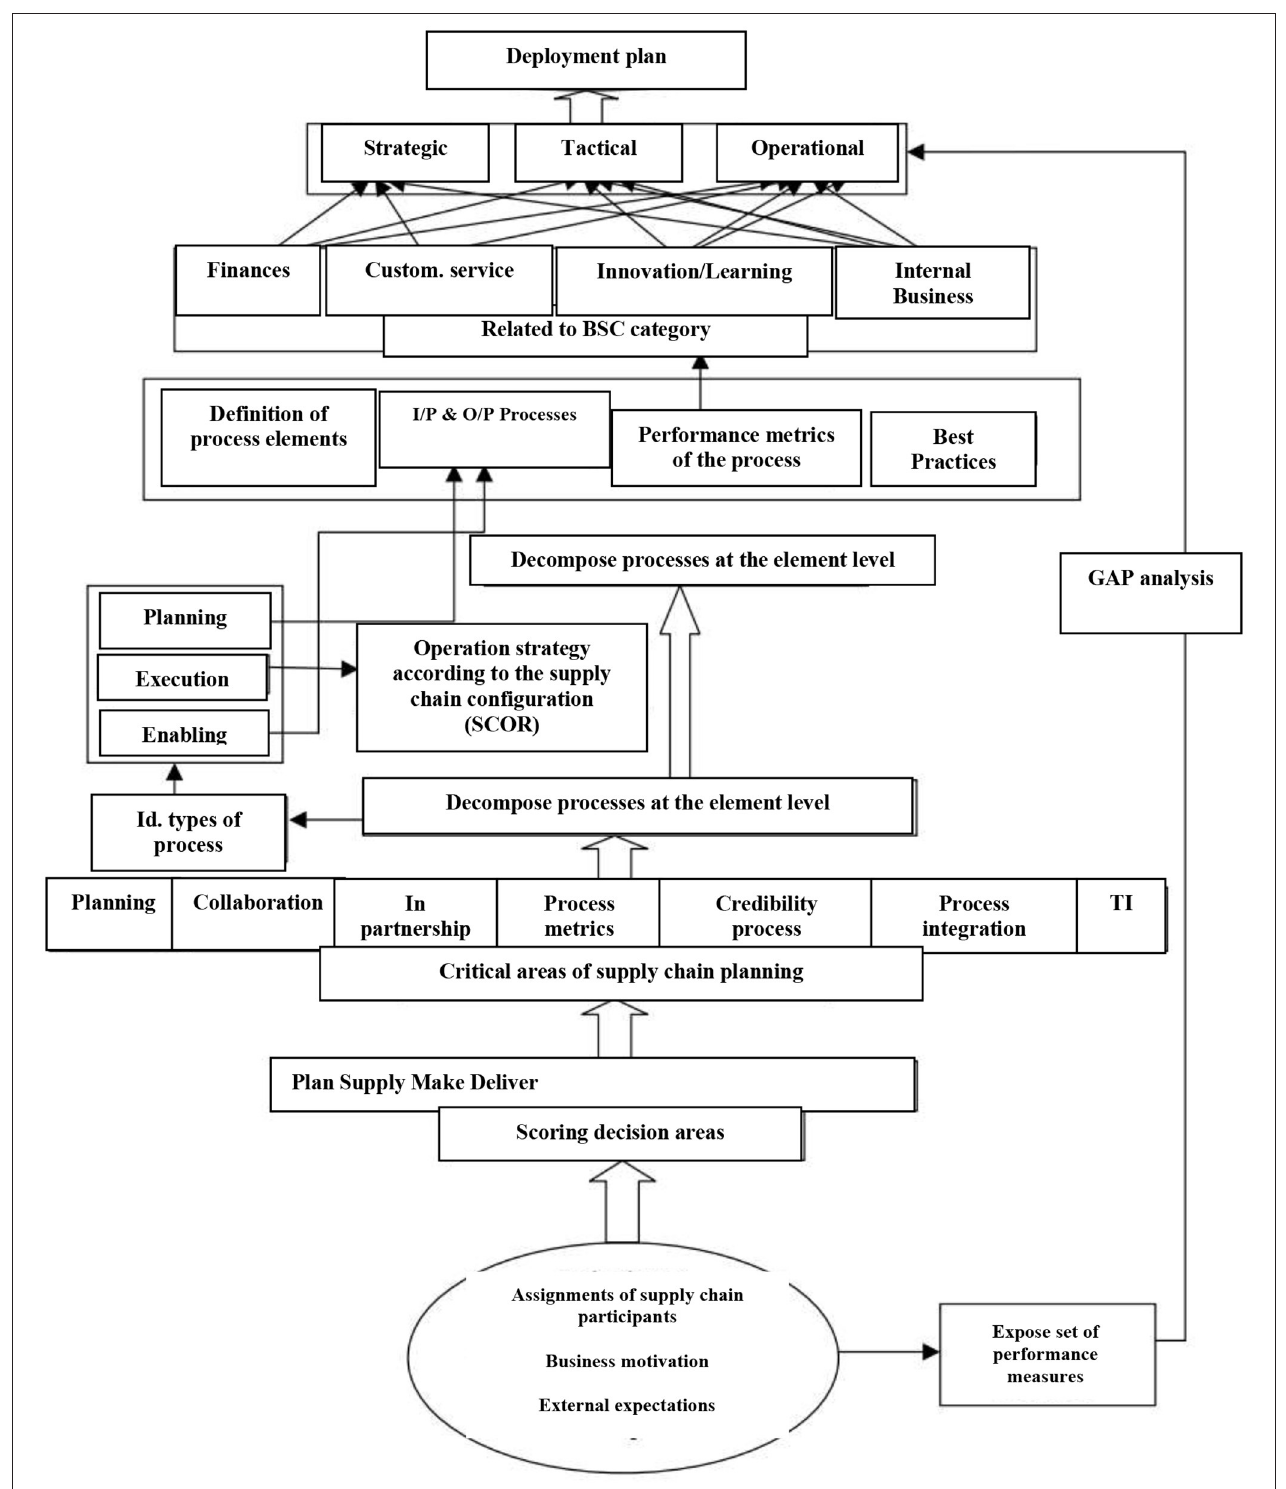
FIGURE 4 | Scor-BSC structure for small and medium-sized companies. Source: Thakkar et al. (2009).